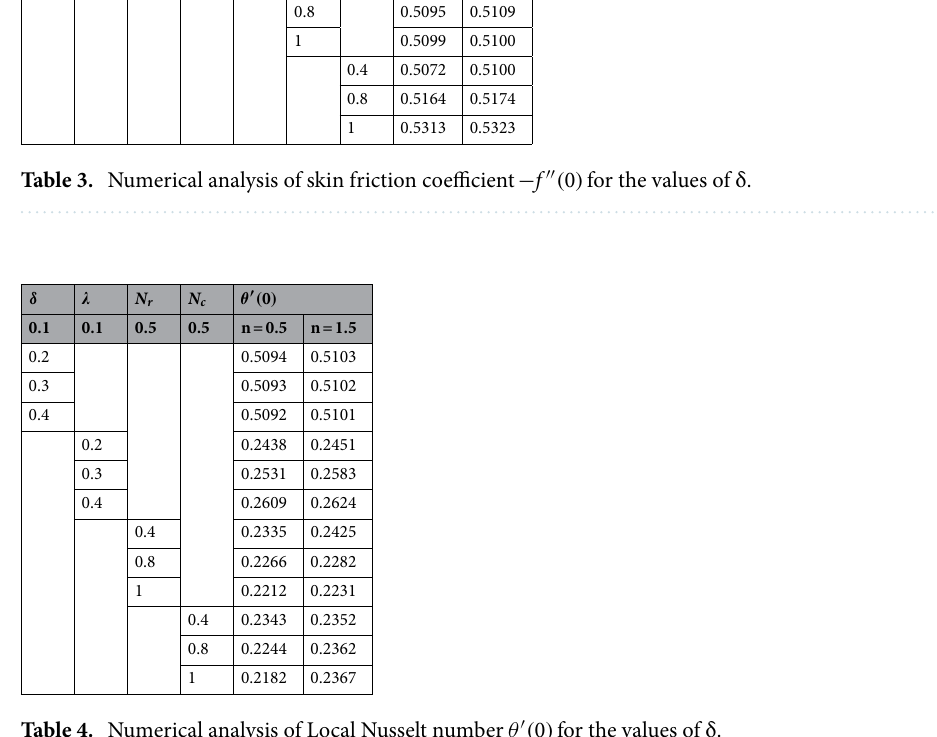
Table 4. Numerical analysis of Local Nusselt number θ ′ ( 0 ) for the values of